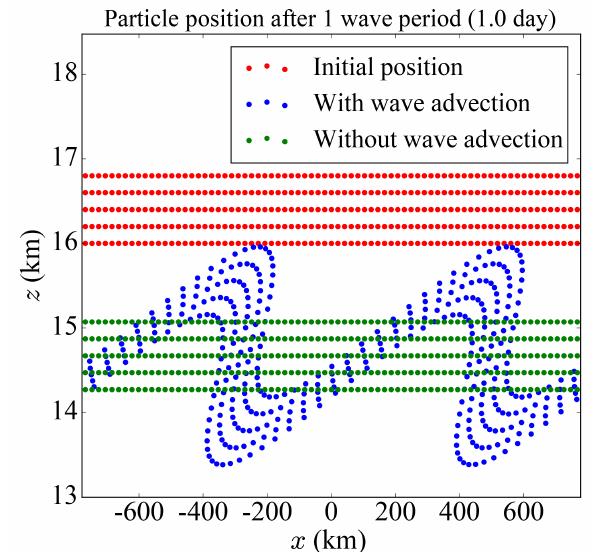
Figure 1. Evolution of the positions of sedimenting particles (ini- tial positions in red) being advected by the wind field induced by a monochromatic wave (blue dots) or not (green dots) during one wave period. See text for a full description of the wave characteris- tics. Also note that the vertical scale has been enhanced by a factor of about 200 compared to the horizontal scale.